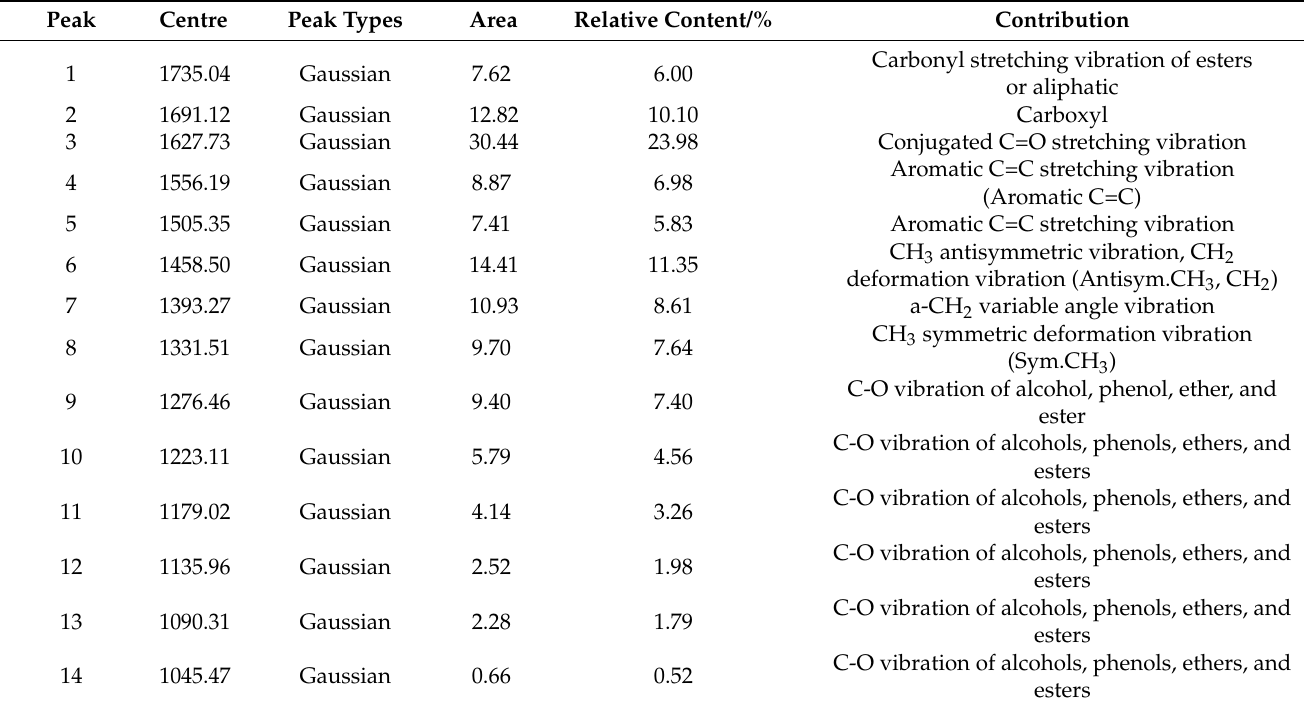
Table 10. Oxygen-containing functional group parameters of Kerjian coal.